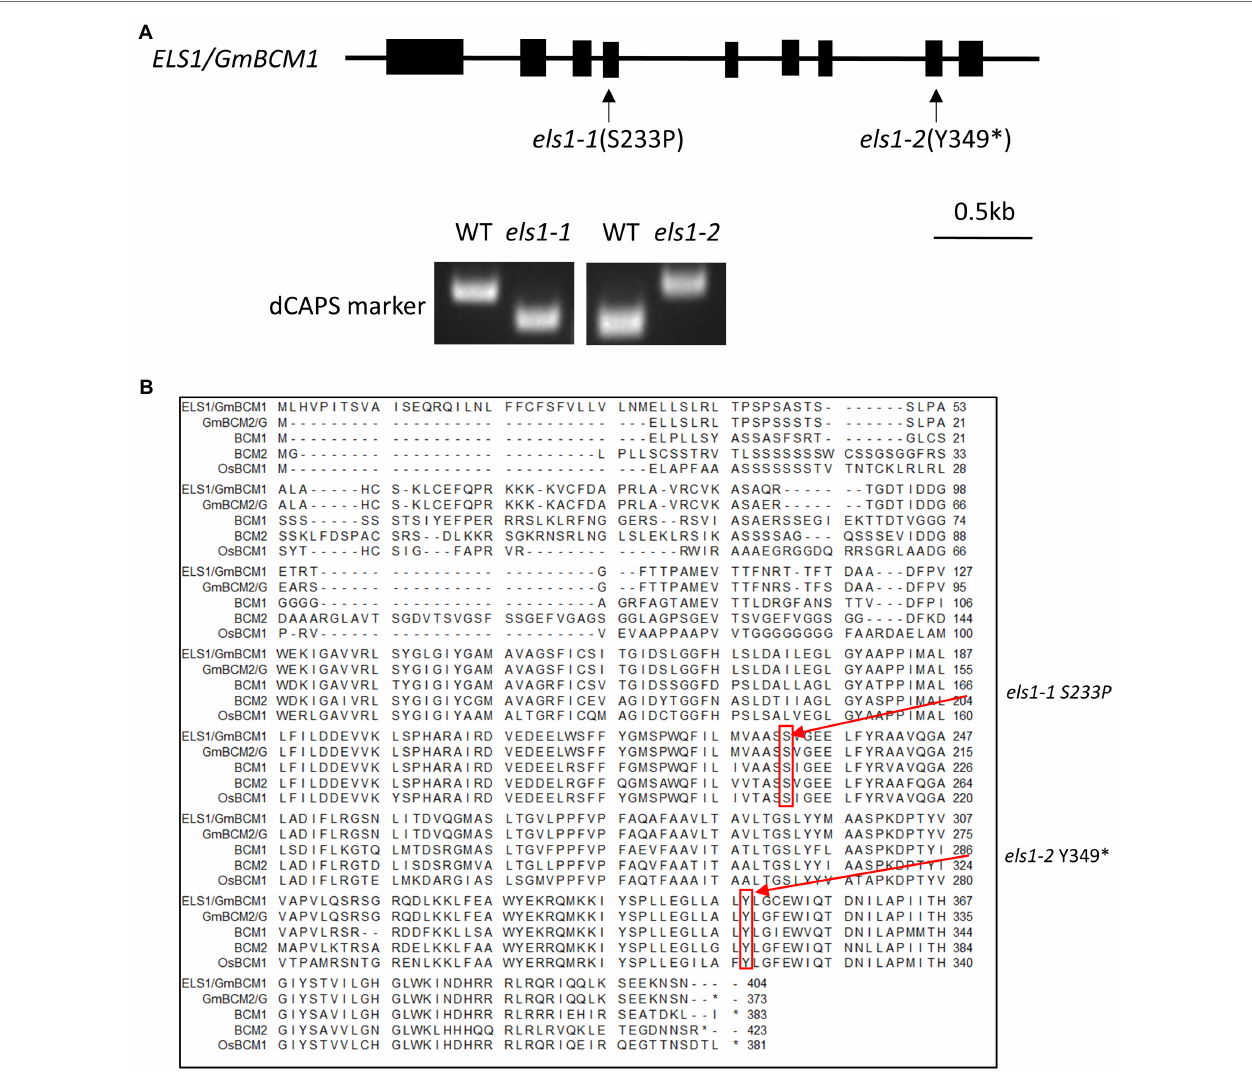
FIGURE 2 | Isolation of ELS1/GmBCM1. (A) Gene structure of ELS1 / GmBCM1. Black boxes indicate exons. Arrows indicate the positions of mutations. els1-1 had an amino acid substitution from serine to proline at position 233, and els1-2 had a nonsense mutation at position 349. The dCAPS marker was developed at the position of the base substitution. (B) Alignment diagram of ELS1 / GmBCM1. The red arrows indicate the positions of mutations. els1-1 and els1-2 have single-base-substitution causing amino acid substitution in ELS1/GmBCM1. BCM1; AT2G35260 ( A. thaliana ), BCM2; AT4G17840 ( A. thaliana ), OsBCM1; Os03g0100030 ( O. sativa ). The asterisk “*” indicates a single nucleotide substitution resulting in a premature termination at the amino acid